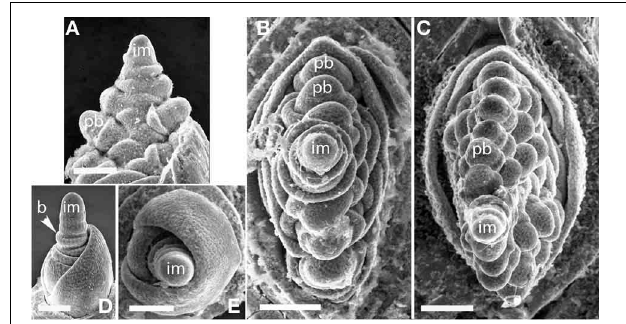
FIGURE 6 | (A–C), Glyceria striata . (A,B) Distichous primary branch formation in the plane of the leaves; (C) secondary branches forming on one side of the inflorescence (to the right in the photo). (D,E) Melica nitens (Meliceae), distichous bract formation. im, inflorescence meristem; pb, primary branch; b, bract. Scale bars: (A–E) , 100 µ m.